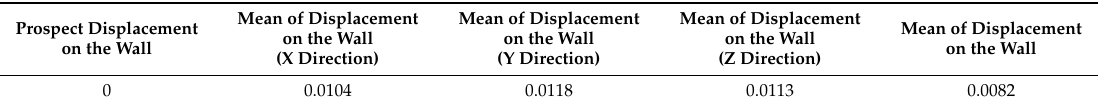
Table 2. Precision of the combined network adjustment between the two epochs for displacement monitoring via CPDA methodology (in meters). Table 3. Average difference in measured wall displacement via photogrammetry between the two epochs (in